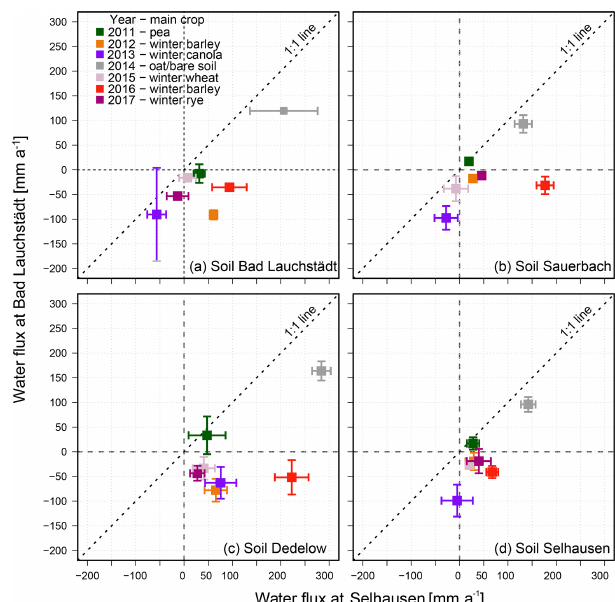
Figure 4. Comparison of net fluxes for the same soils at two sites: annual observed net soil water flux at 1.5m soil depth of soils from (a) Bad Lauchstädt, (b) Sauerbach, (c) Dedelow and (d) Selhausen under a dry climate (Bad Lauchstädt) and wet climate (Selhausen) for the years between 2011 and 2017; average values (symbols) and standard deviations (error bars) for observations are from the same